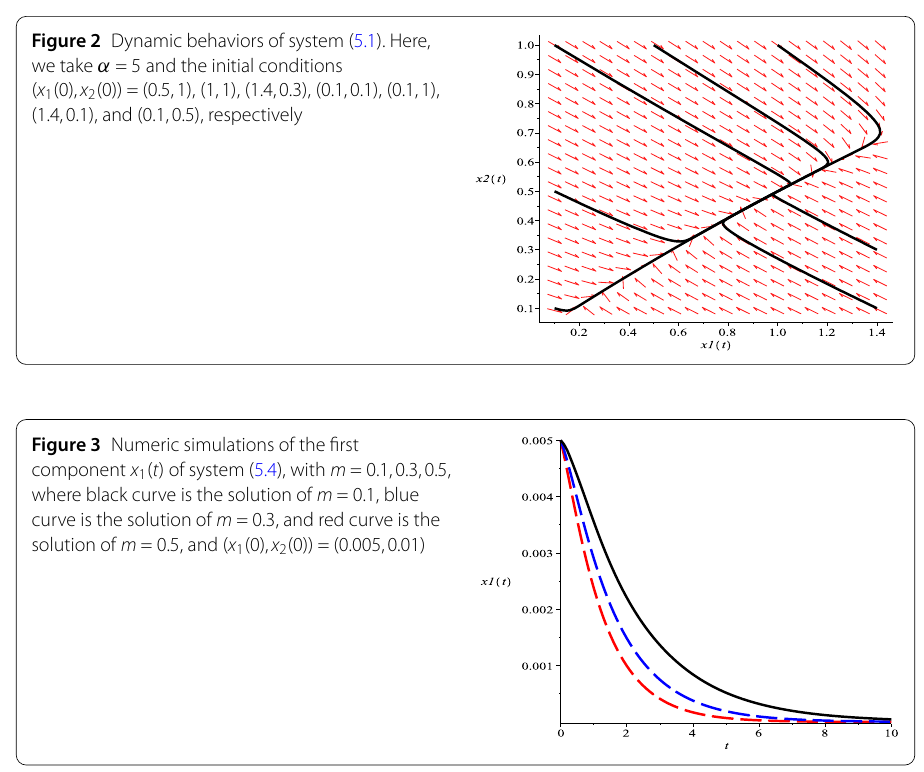
Figure 2 Dynamic behaviors of system (5.1). Here, we take α = 5 and the initial conditions